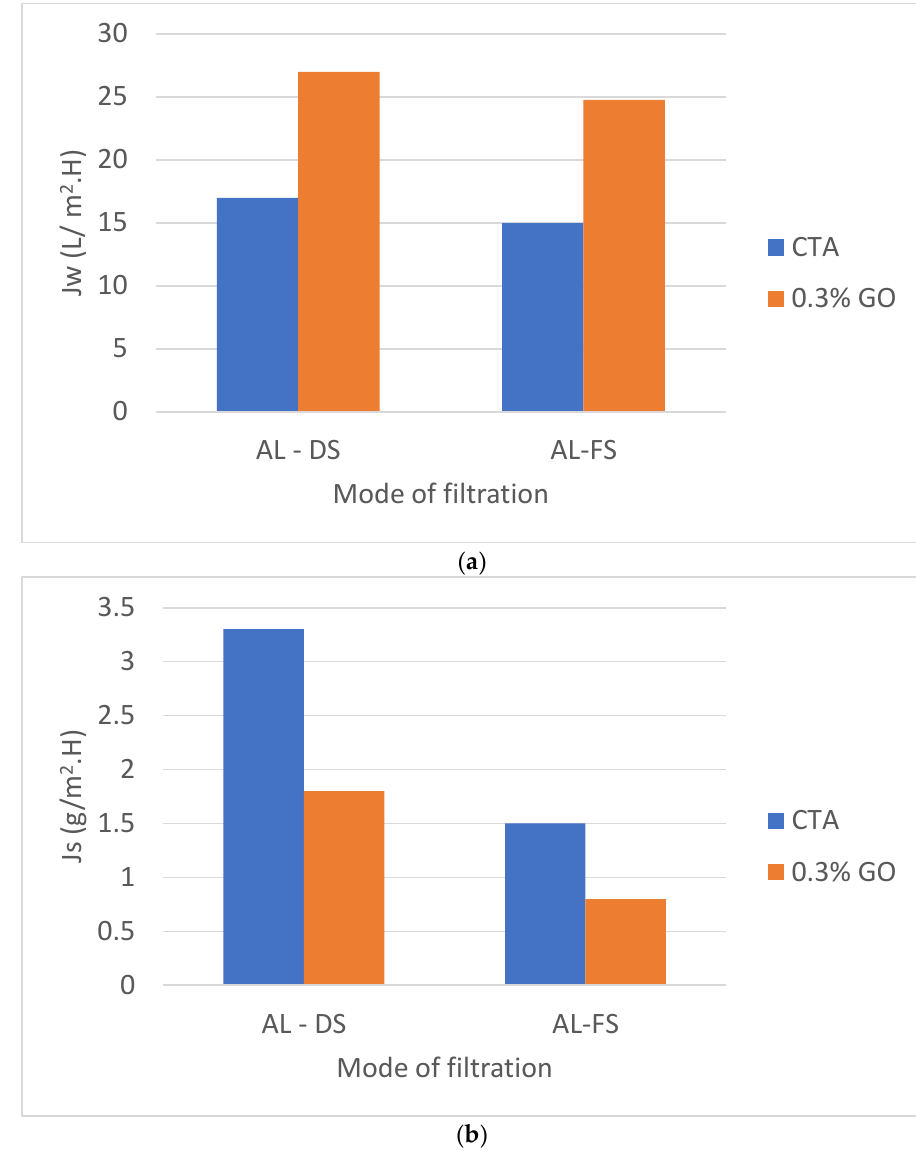
Figure 9. The effect of membrane orientation on ( a ) the water flux of and ( b ) on the reverse salt flux of CTA/0.3% GO compared with CTA membrane.